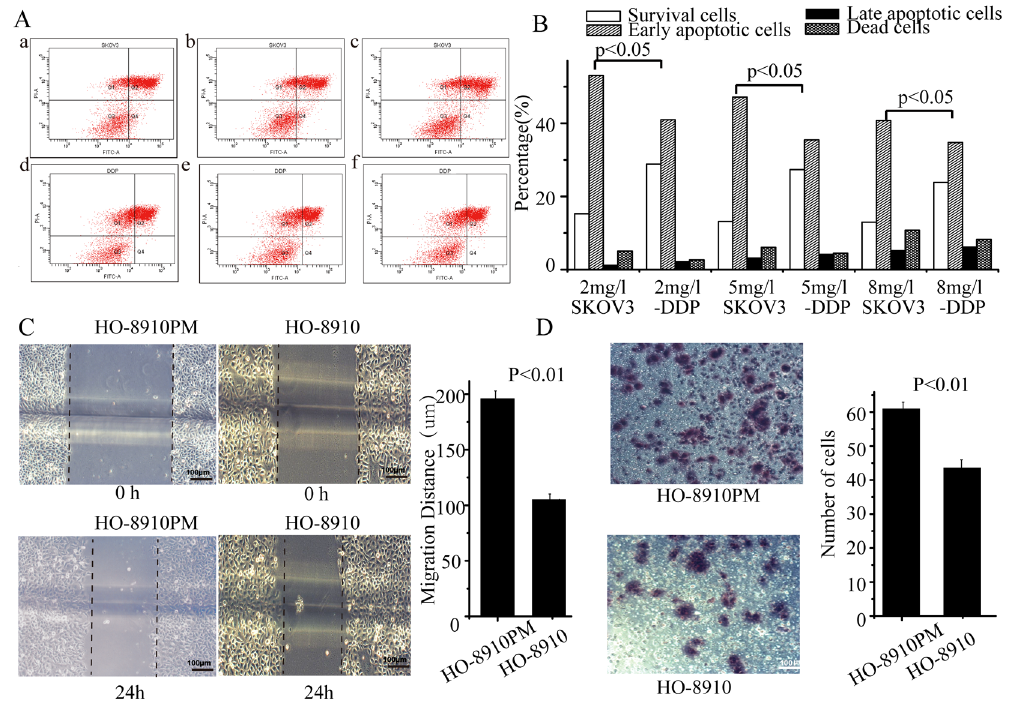
Figure 1. Different biological behaviours in two pairs of ovarian cancer cell lines. In flow cytometry ( A ), a–c were SKOV3 cell lines and d–f are SKOV3-DDP cell lines treated with 2, 5, or 8 mg/l of cisplatin. Q1, Q2, Q3, Q4 represent dead cells, late apoptotic cells, survival cells, and early apoptotic cells, respectively. At different concentrations of 2, 5, or 8 mg/l, SKOV3 and SKOV3-DDP cells have significant differences in cisplatin resistance ( p < 0.05) ( B ). For HO-8910PM and HO-8910 cell lines, pictures were taken of the cells at 0 h, then incubated overnight, and photographed again. Cell migration distance in the HO-8910 cell line was less than that in the HO-8910PM cell line (p < 0.01) ( C ). Cells were incubated on migration wells for 48 h, the number of cells that migrated to the lower side of the filter were counted ( D ). The results are shown as the mean ± SD ( p < 0.01 compared to the HO-8910 cell